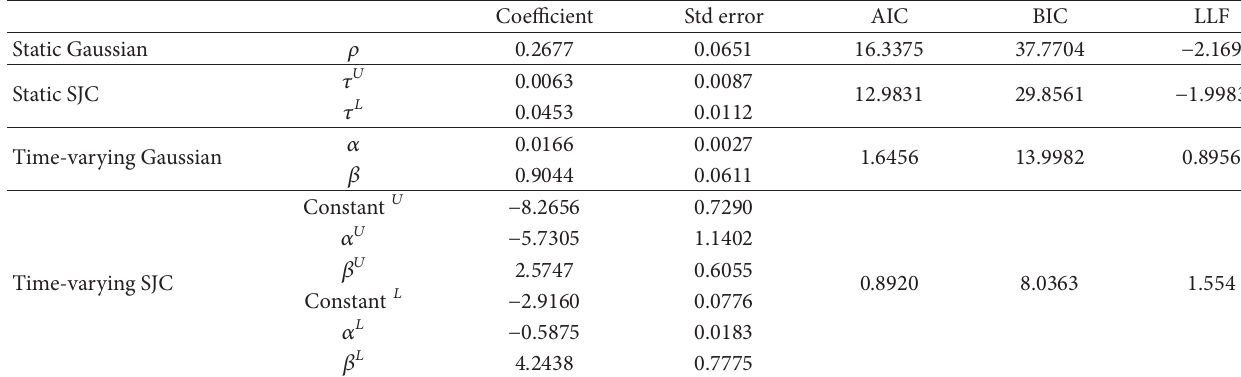
Table 3: Results for the copula models.